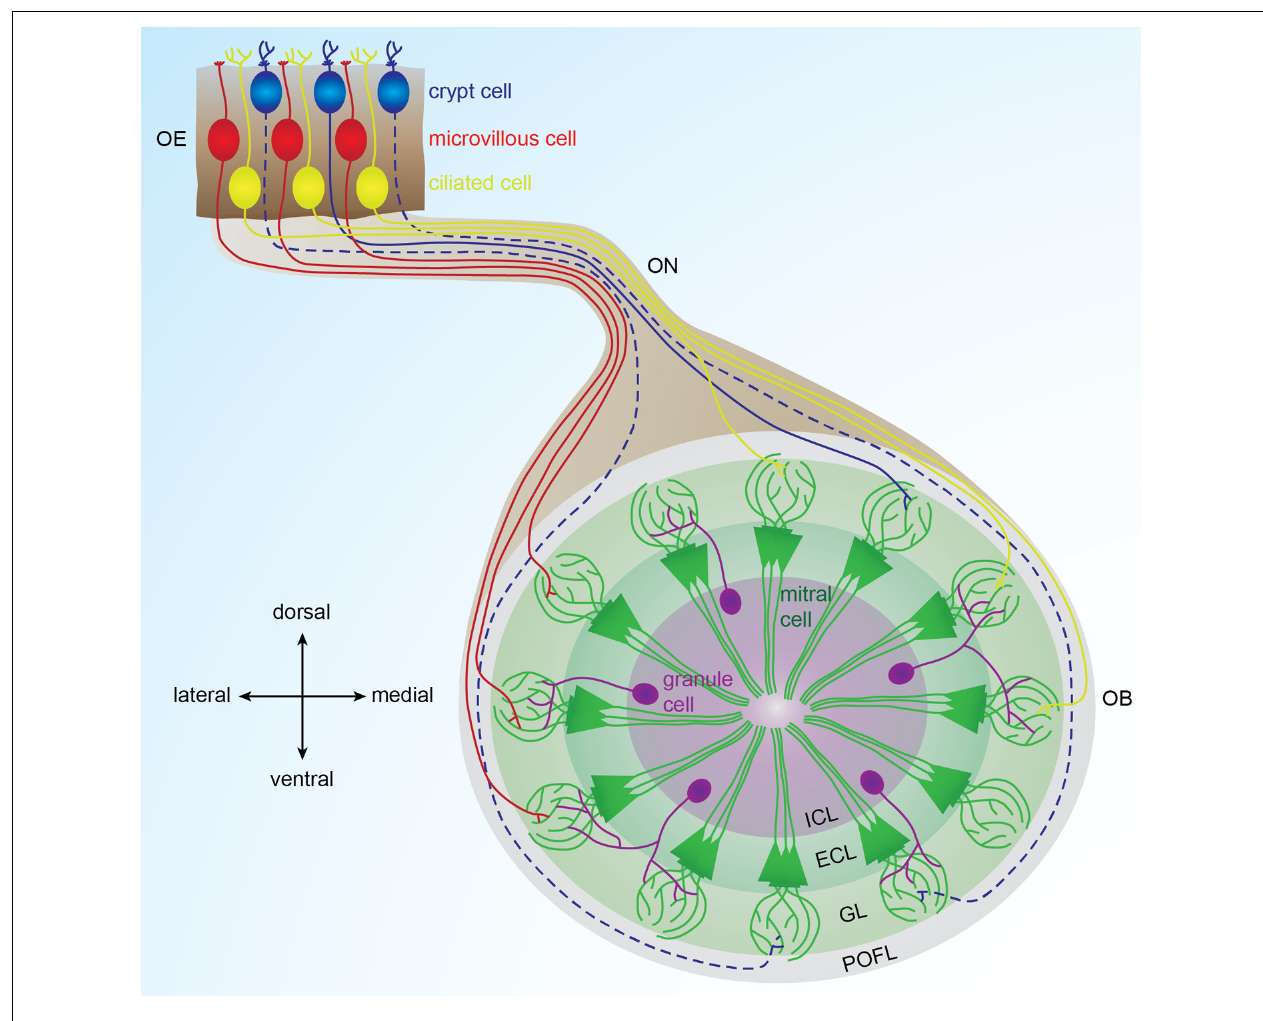
neuron axons contact dendrites of mitral cells, the output cells of the olfactory bulb. Inhibitory interneurons called granules cells are located in the deepest layer of the bulb and modulate the activity of mitral cells. Solid lines represent connections described in zebrafish. Dotted lines represent connections described in other fish species. OE: olfactory epithelium, OB: olfactory bulb, ON: olfactory nerve, POFL: primary olfactory fiber layer, GL: glomerular layer, ECL: external cell layer, ICL: internal cell